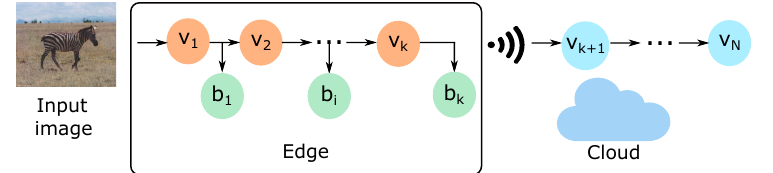
Figure 2. Adaptive edge offloading using early-exit DNNs. Adapted from the paper